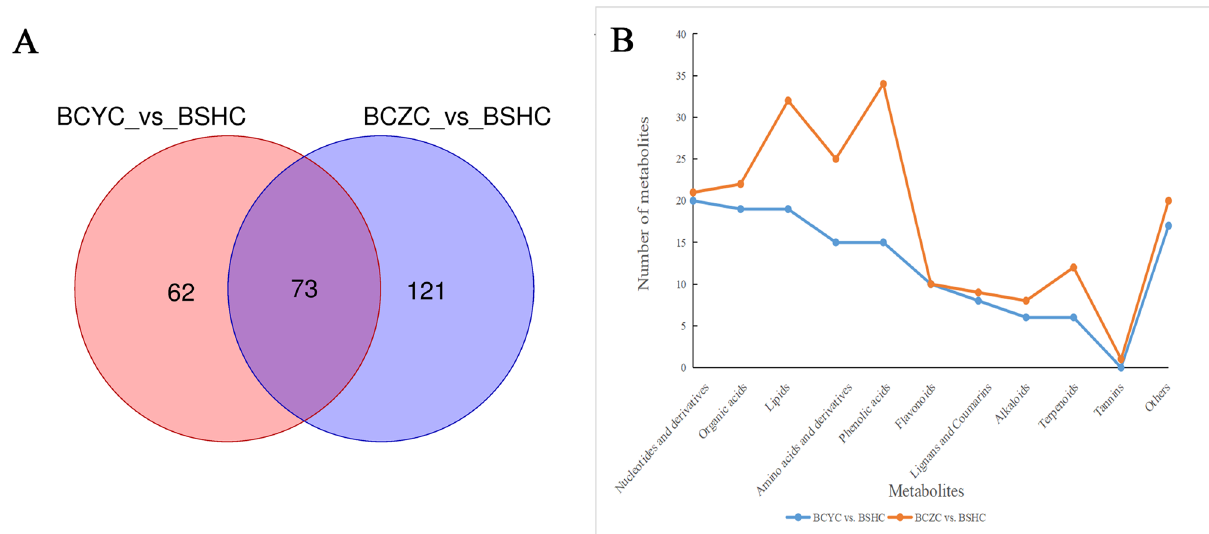
Figure 2. Differential metabolite analysis between B. chinense and B.scorzonerifolium. ( A ) Venn diagram of differential metabolites (BCYC vs. BSHC and BCZC vs. BSHC) . ( B ) Line chart of differential metabolites (BCYC vs. BSHC and BCZC vs.